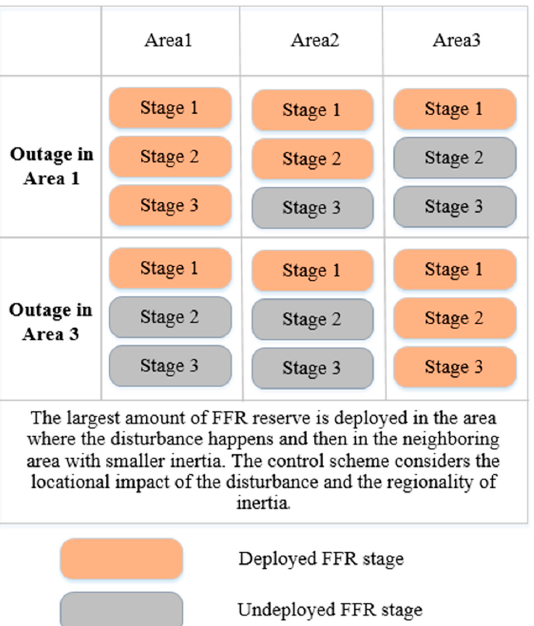
Figure 18. FFR deployment for different location of the disturbance.